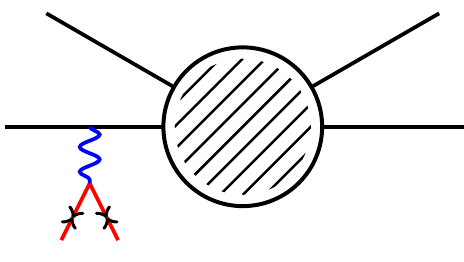
Figure 6 . Feynman diagram for double soft gravitini |